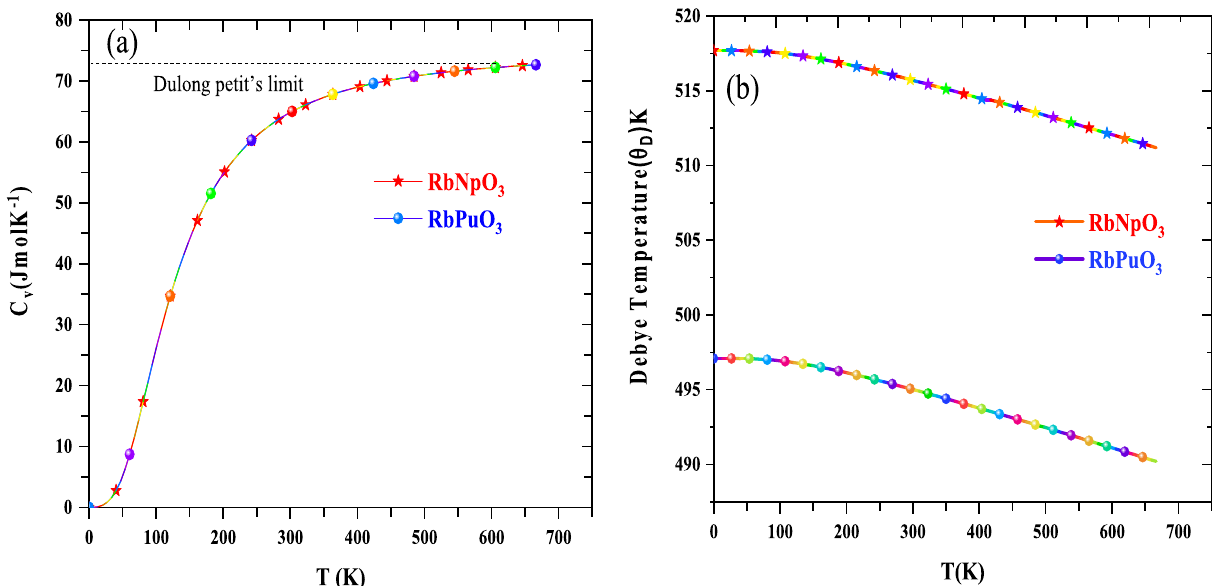
Figure 9. Thermodynamic features of RbMO 3 perovskites as a function of temperature: ( a ) Specific heat, ( b ) Debye